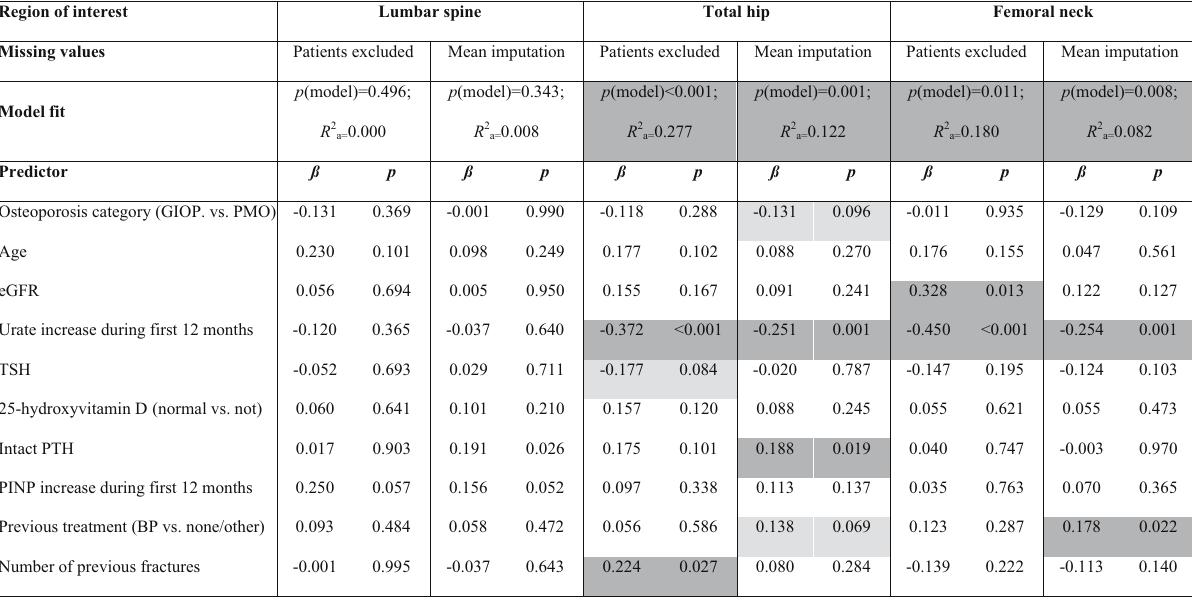
Table 4: Summary of multiple linear regression models for predicting increase in BMD from 12 to 24 months ( n = 168 patients who completed the treatment ) kcenlaromeFpihlatoTenipsrabmuLtseretnifonoigeR Missing values